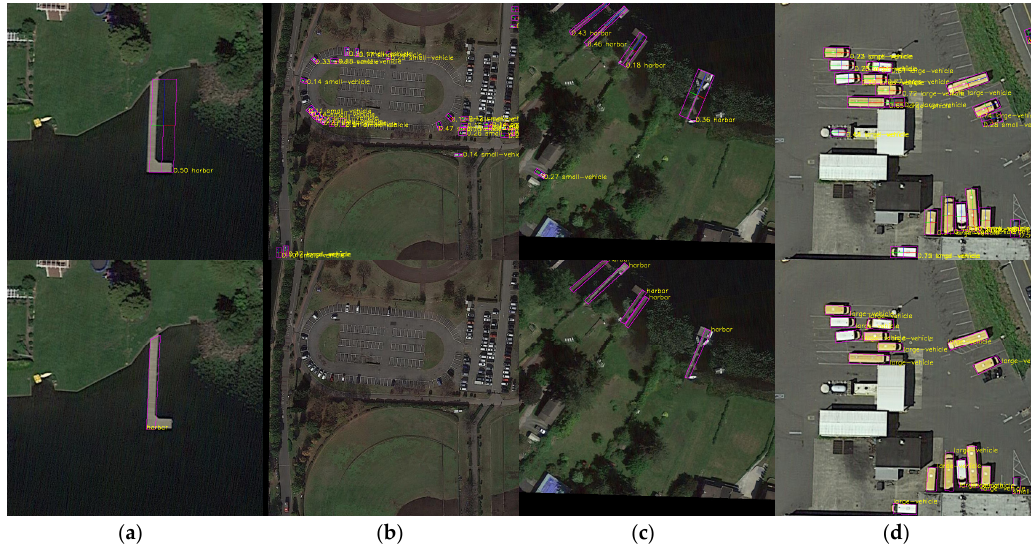
Figure 12. Examples of the O2DFFE model detection failures on the DOTA1.0 dataset. ( a ) Label definition is inaccurate. ( b ) Small objects are detected. ( c , d ) Confusion resulting from complex backgrounds.